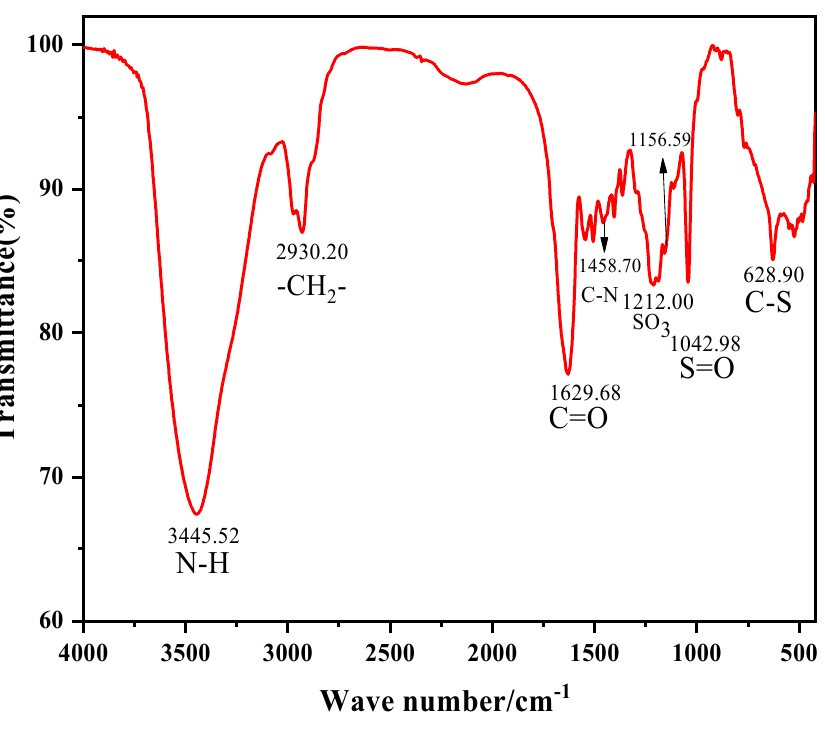
Figure 1. FTIR spectrum of DNDAP.